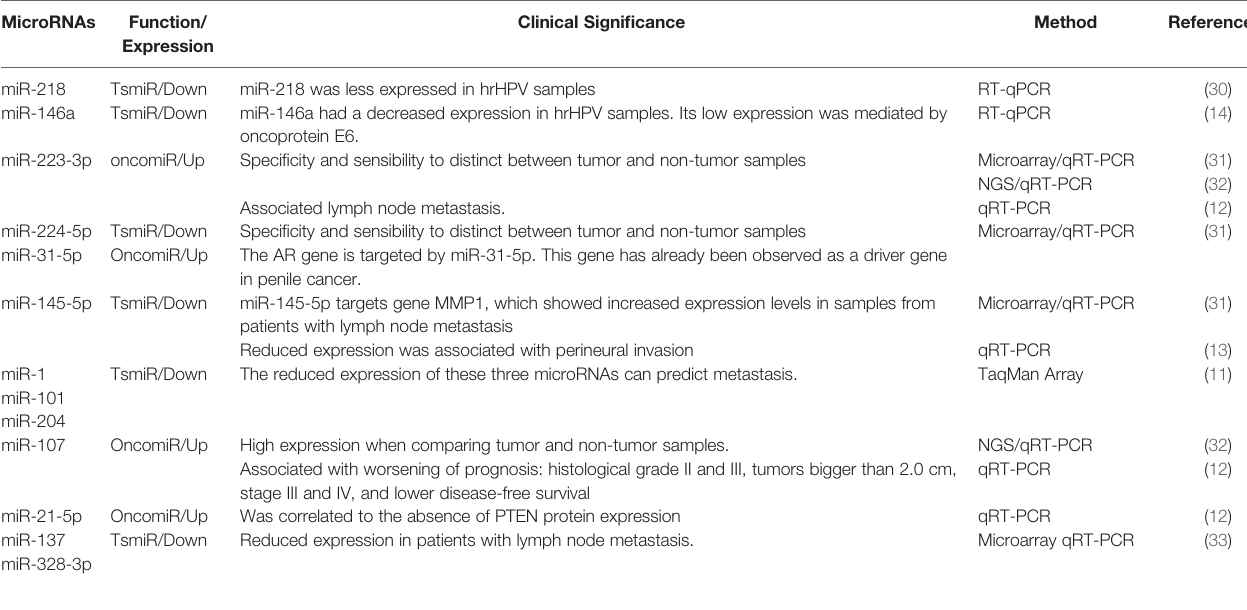
TABLE 1 | Main microRNA linked to penile